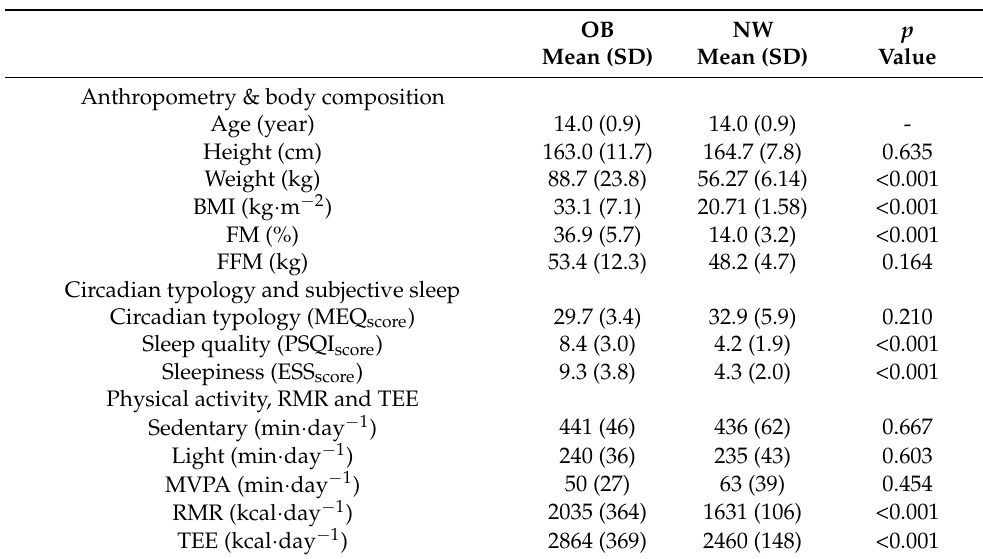
Table 1. Descriptive characteristics, subjective sleep quality, daytime sleepiness, and perceived stress of the sample population.